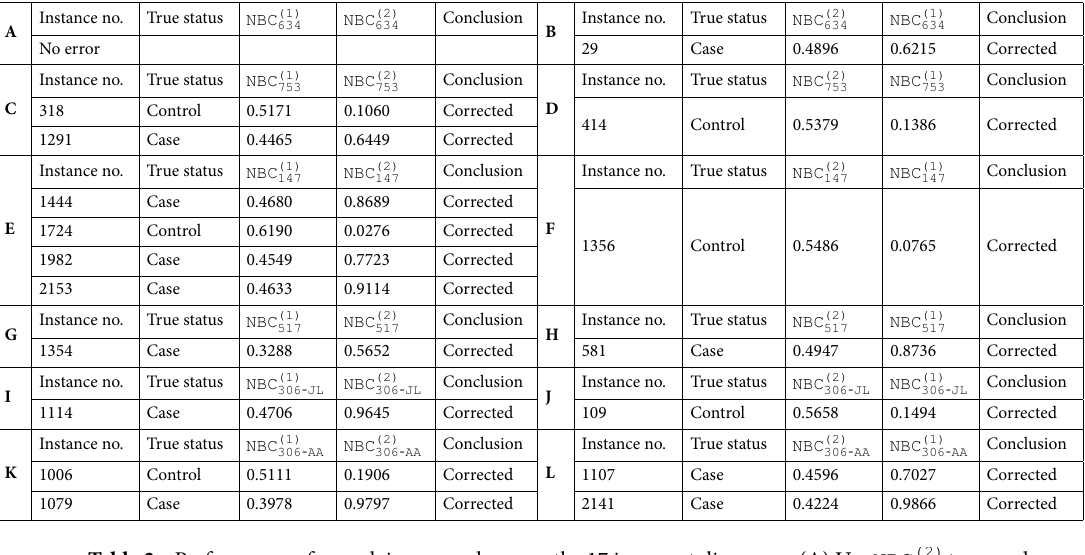
Table 2. Performance of remedying procedures on the 17 incorrect diagnoses. (A) Use NBC